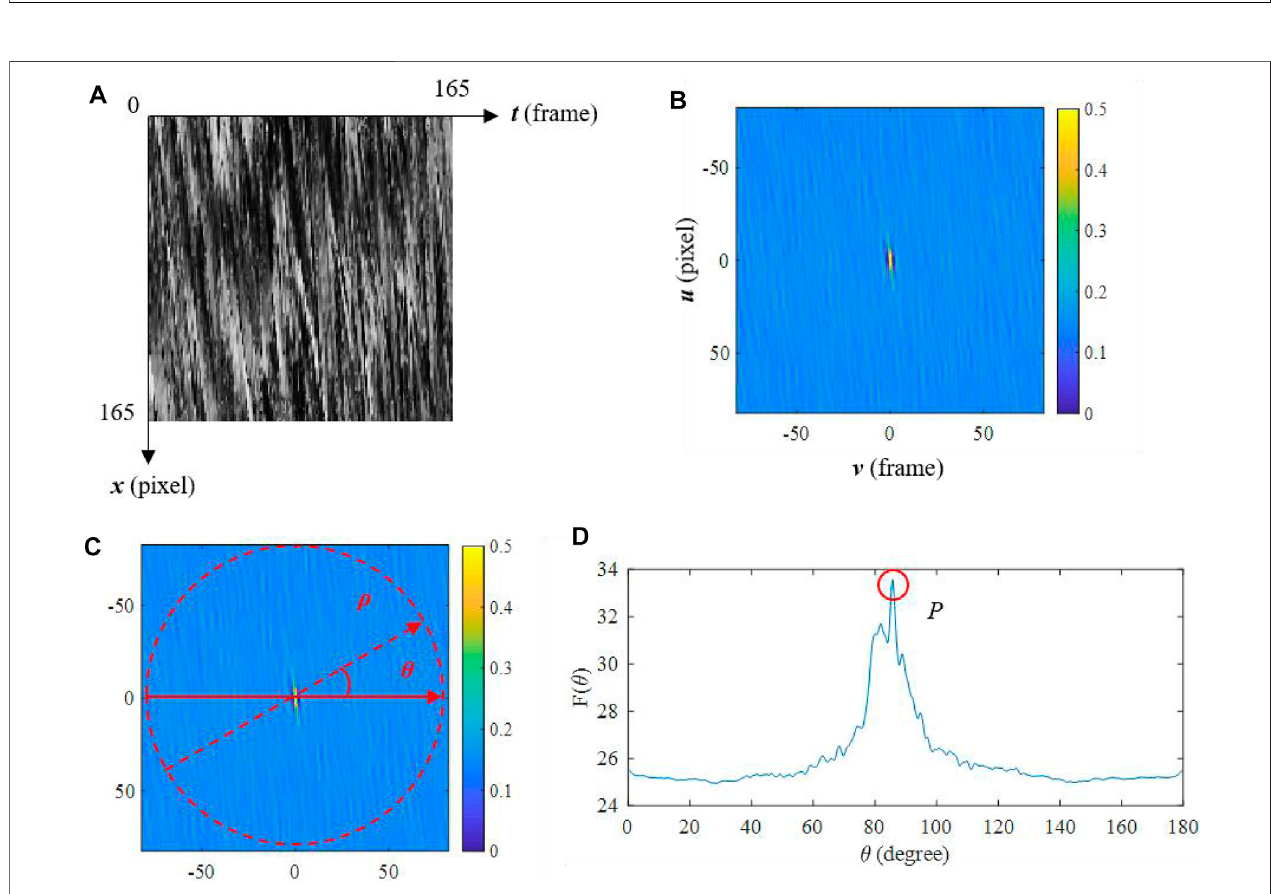
FIGURE 2 | Process of obtaining the magnitude of the velocity. (A) An original STI. (B) The autocorrelation coef fi cient R . (C) A polar coordinate system converted from (B) . (D) F ( θ ) at different angles and p is the maximum value.